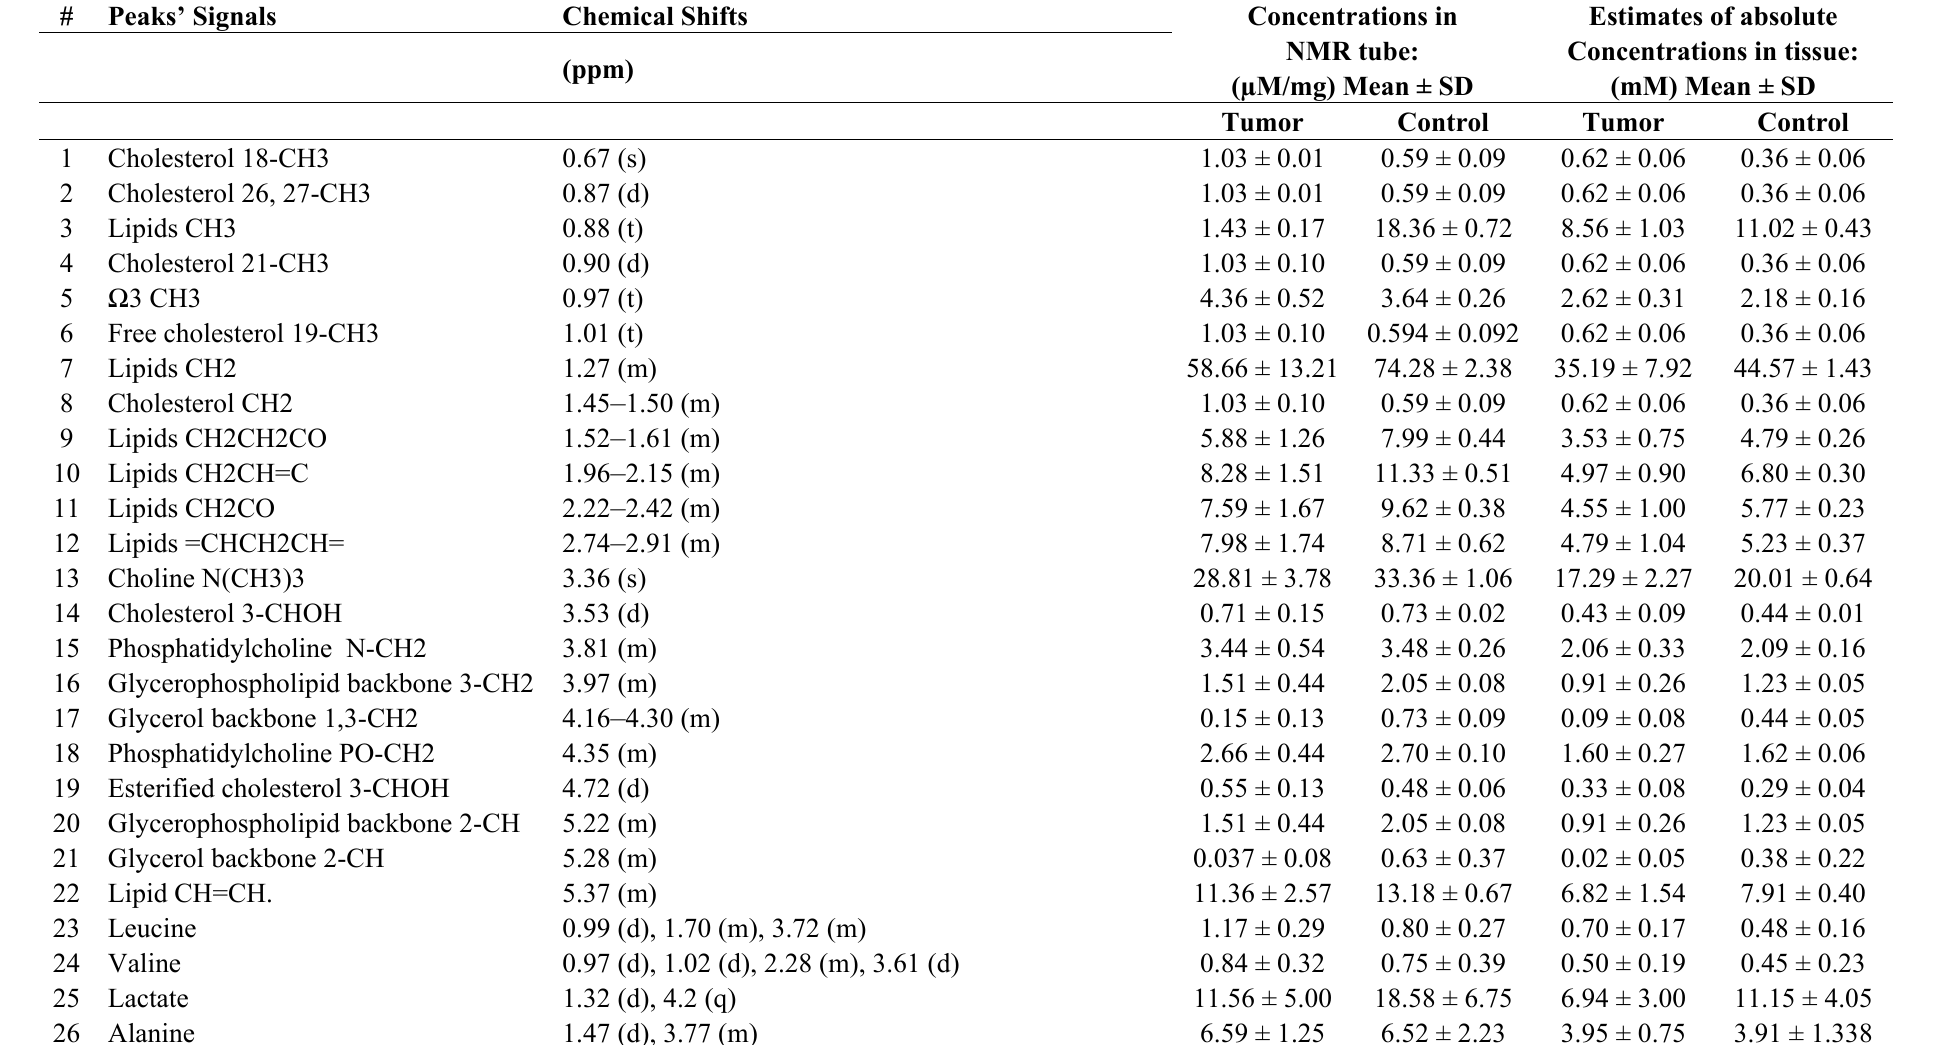
Table 1. Metabolite Peak Assignments and Concentrations of